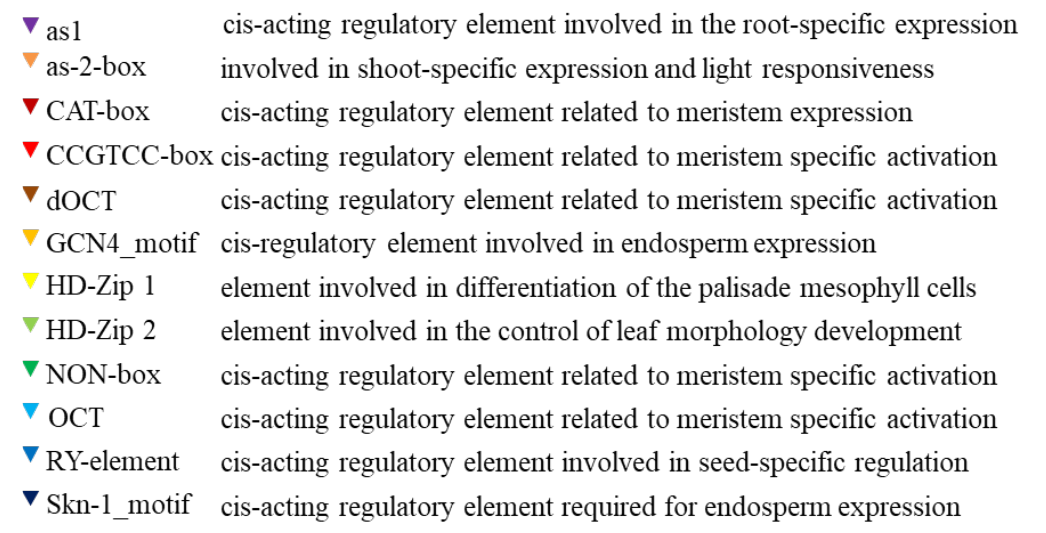
Figure 4. Analysis of tissue-specific cis -element in the 5′ -flanking sequences of plant SF3a2 genes. Twelve putative cis -elements are represented by different symbols as indicated in different colors. The function of every motif is listed next to the symbol. These motifs are marked along 1.5kb 5′ -flanking sequences before every gene. A downward triangle means that this element is on the positive-sense strand. On the contrary, the upturned triangle means it is on the antisense strand. The red dotted line shows no sequences. The black dotted line represents the region of annexed base N. The full line represents the regions with explicit basic pairs.